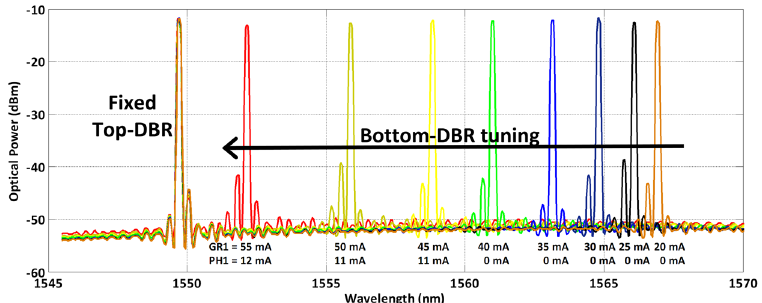
Figure 2. Wavelength tuning of the InP polymer DBR laser, demonstrating a wide tuning range from 18.55 nm (2.25 THz) to 2.64 nm (330 GHz), varying the current applied to the grating section (GR) and the phase section